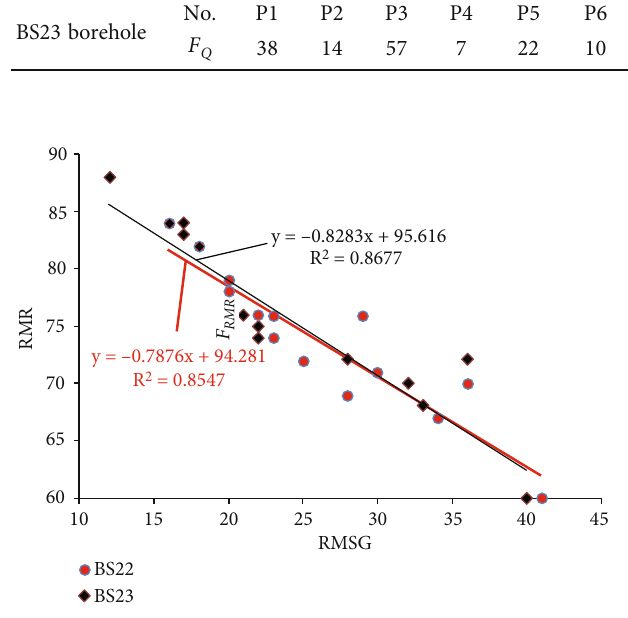
Figure 5: Relationship between RMSG and F around BS22 and BS23 boreholes.